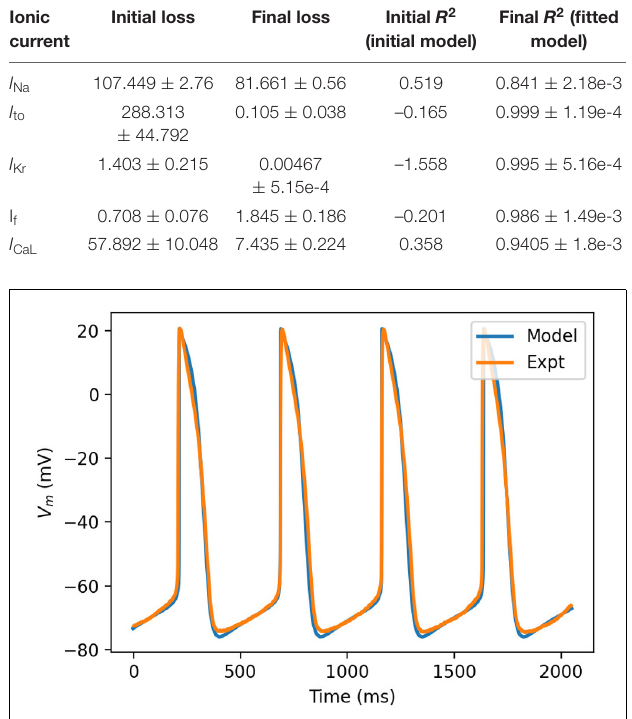
FIGURE 5 | Comparison of simulated action potential morphology (blue) to experimentally recorded (orange).